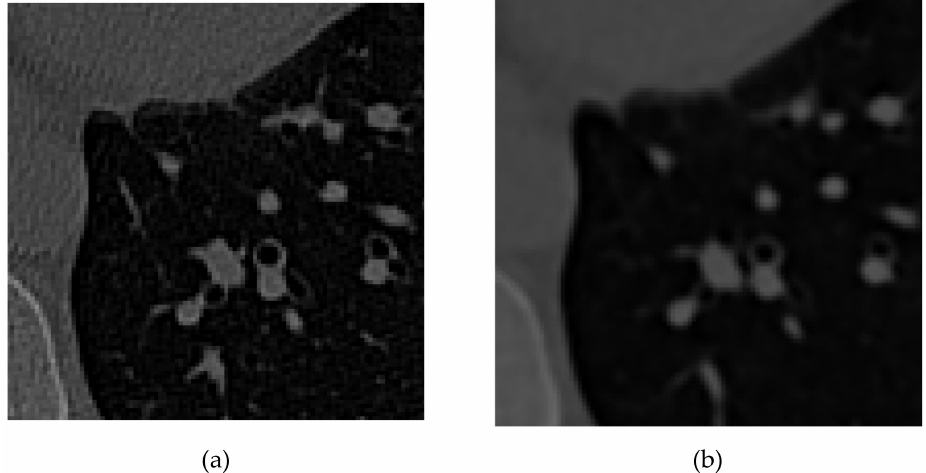
Figure 2. Image contrast processing comparison diagram: ( a ) before processing ( b ) after